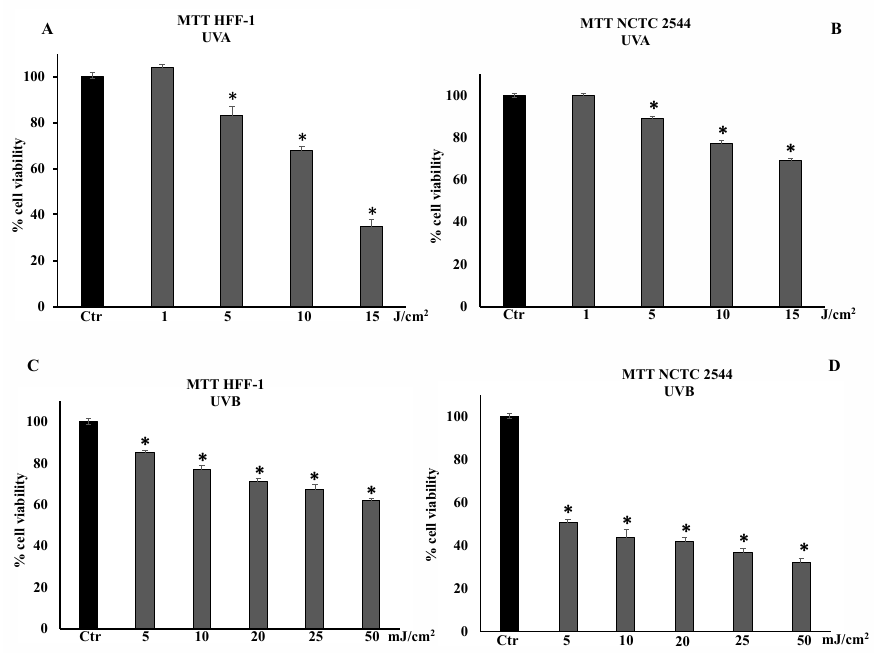
Figure 1. Cell viability in HFF-1 and NCTC 2544 non-irradiated (Ctr) and irradiated with UVA ( A , B ) and UVB ( C , D ) at different doses. Values are the mean ± S.D. of five experiments in triplicate. * Significant vs. untreated control cells: p < 0.001.